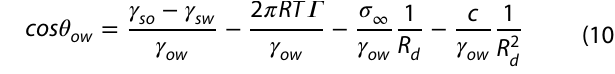
Table 7. The negative line tension to IFT ratios in Table 7 show negative line tensions in presence of surfactant